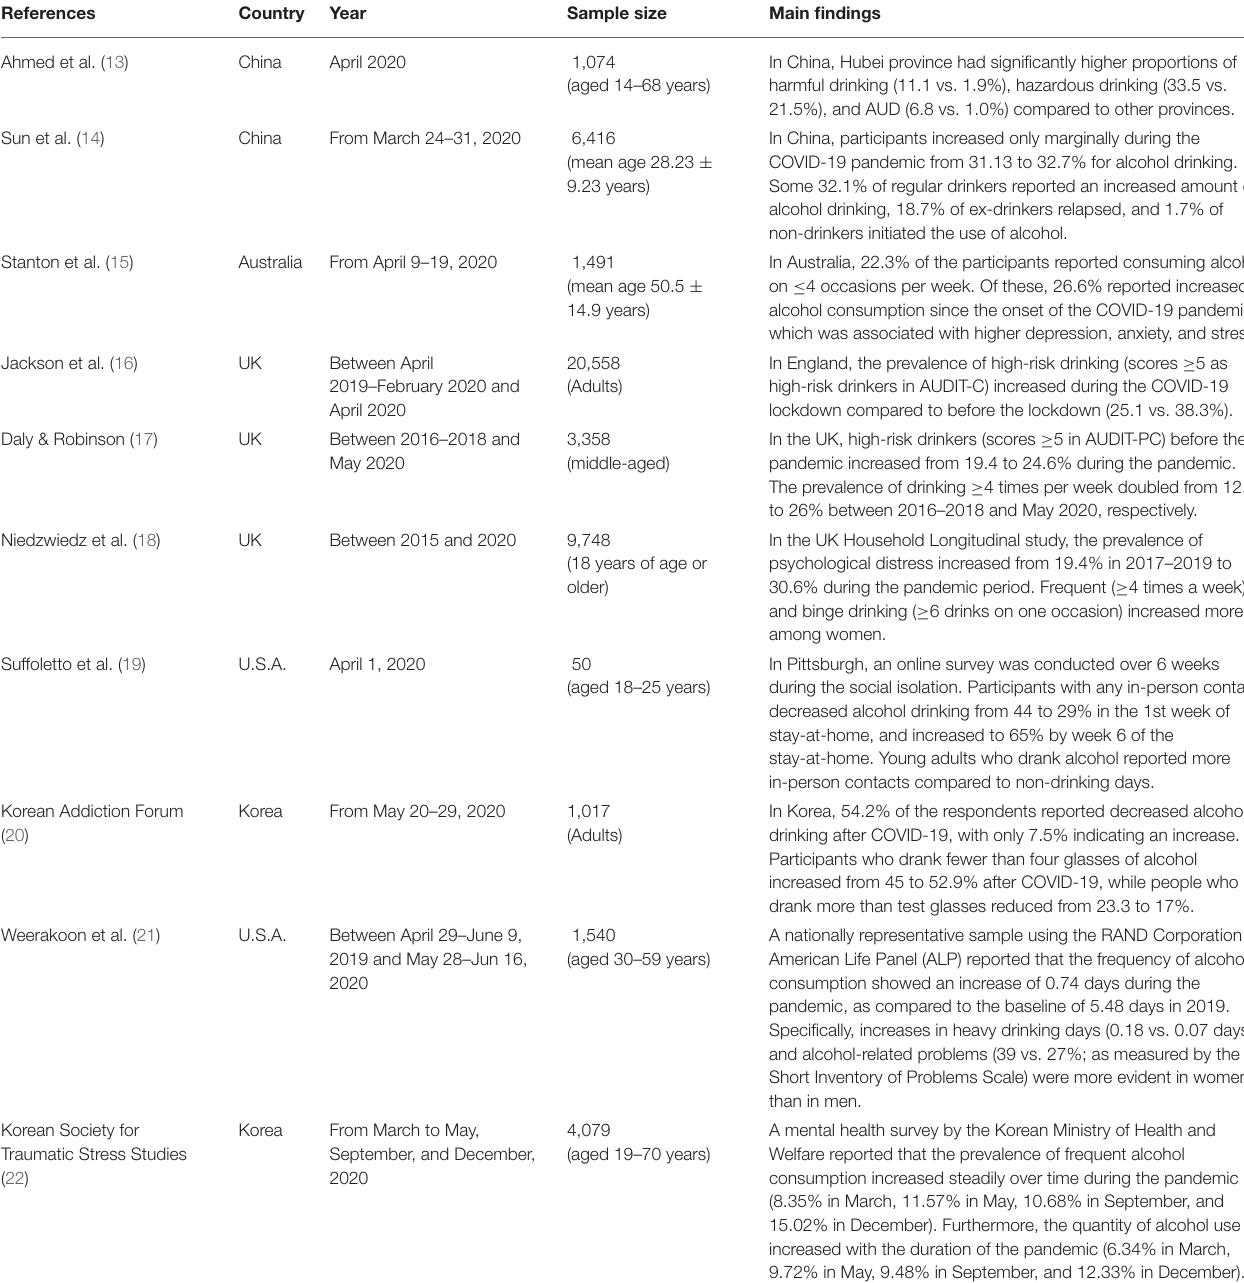
TABLE 1 | Literature review of alcohol consumption behavior during the COVID-19